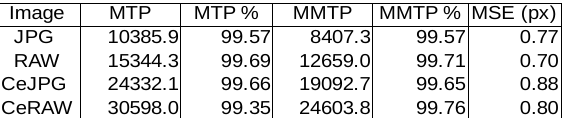
Table 1. Comparison between results on jpg and raw images with and without contrast enhancement ( CeJPG , CeRAW - contrast enhanced JPG and, respectively, RAW images; MTP - mean of number of tie-points per image; MTP % - mean percentage of used tie- points; MMTP - mean of multiple tie-points wich are tie-points between more than two images; MSE - mean squared error).